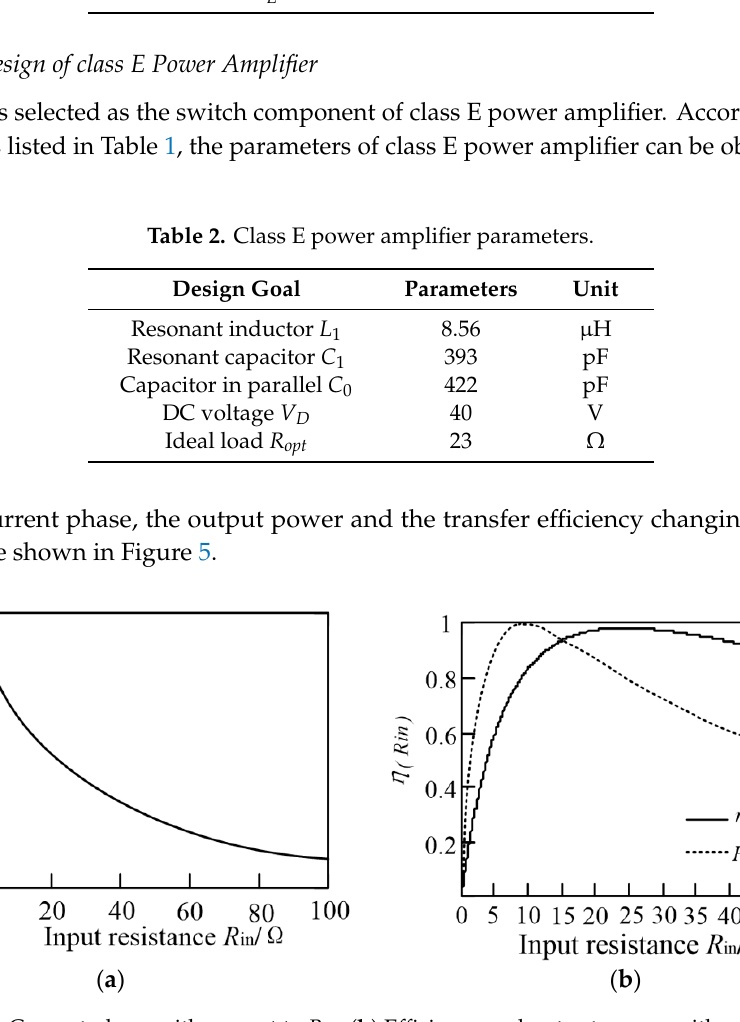
Figure 4. Flow chart of design progress.